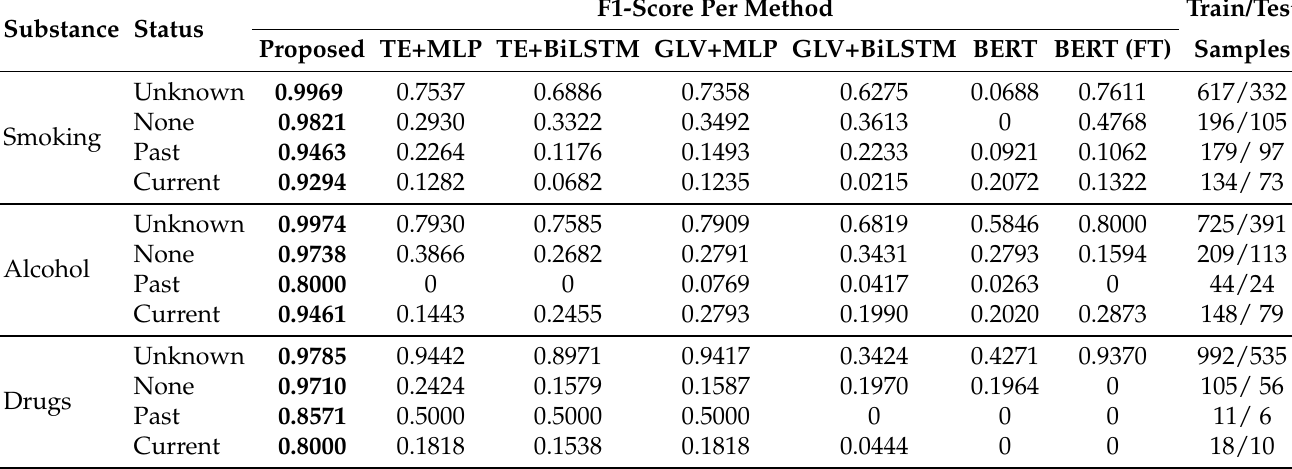
Table 8. Substance-use status-detection performance (F1-score) using the examined deep learning approaches and the proposed